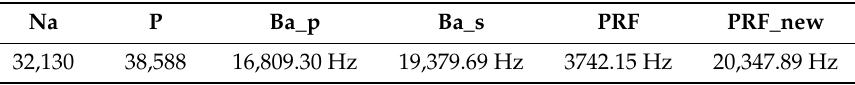
Figure 6. One primary image of GF-3 in ST mode. This image is processed by the two-step algorithm directly. ( a ) The whole image of one data take; ( b ) The local part of ( a ) which is a boat moored at the bank of the Yangtze River that we treat as a corner reflector. Table 4. Some parameters of GF-3 ST mode data before and after